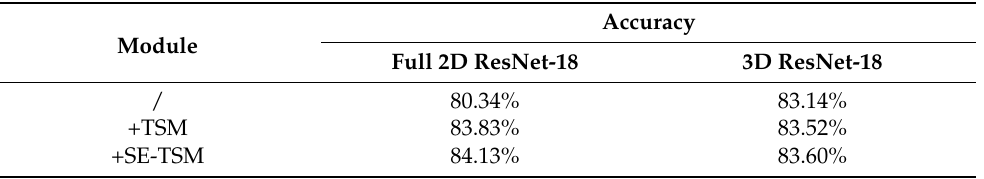
Table 3. The performance of the full 2D ResNet-18 and 3D ResNet-18 on LRW dataset. Results are reported in terms of RANK 1 identification accuracy (%).